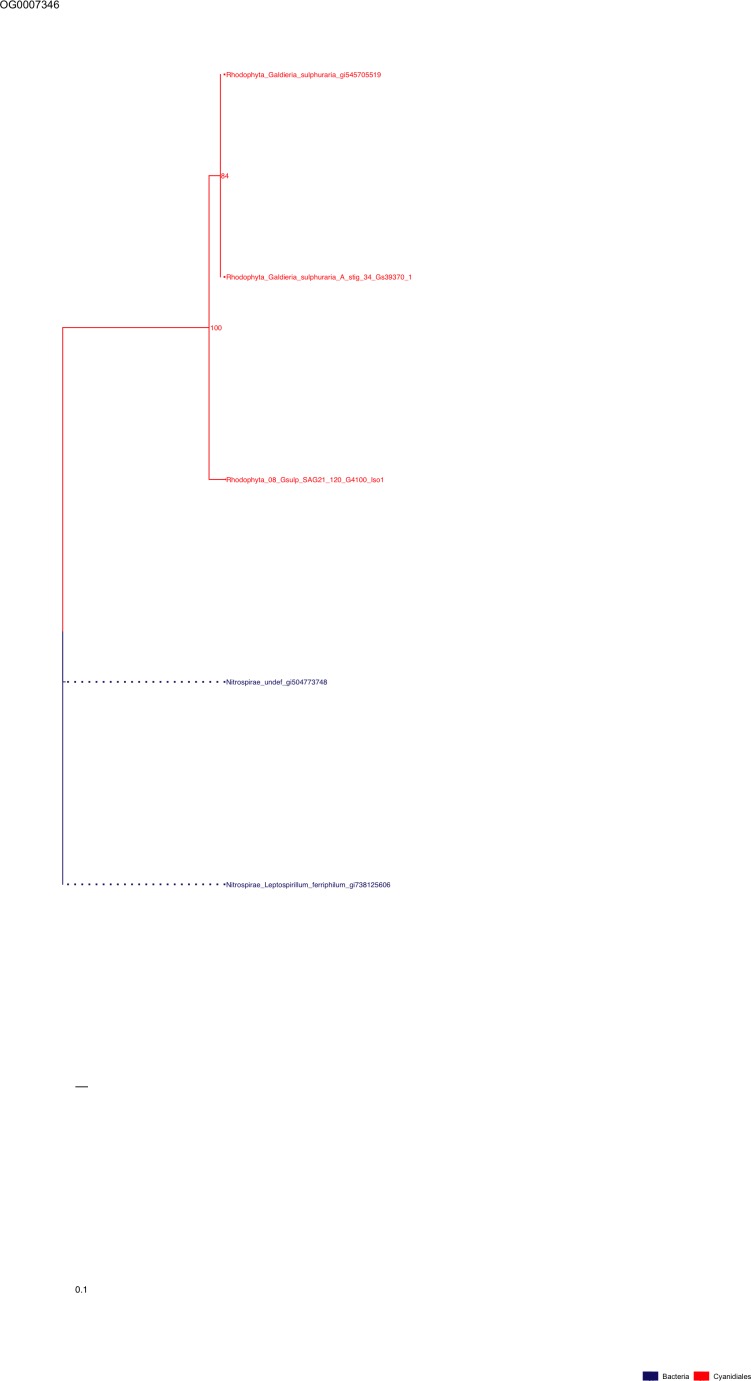
Sequence tree of orthogroup OG0007346.The tree is based on amino acid sequences. Archaea (yellow), Bacteria (blue), Cyanidiales (red), Eukaryotes including other red algae (green). Branches containing Cyanidiales sequences are highlited in red.